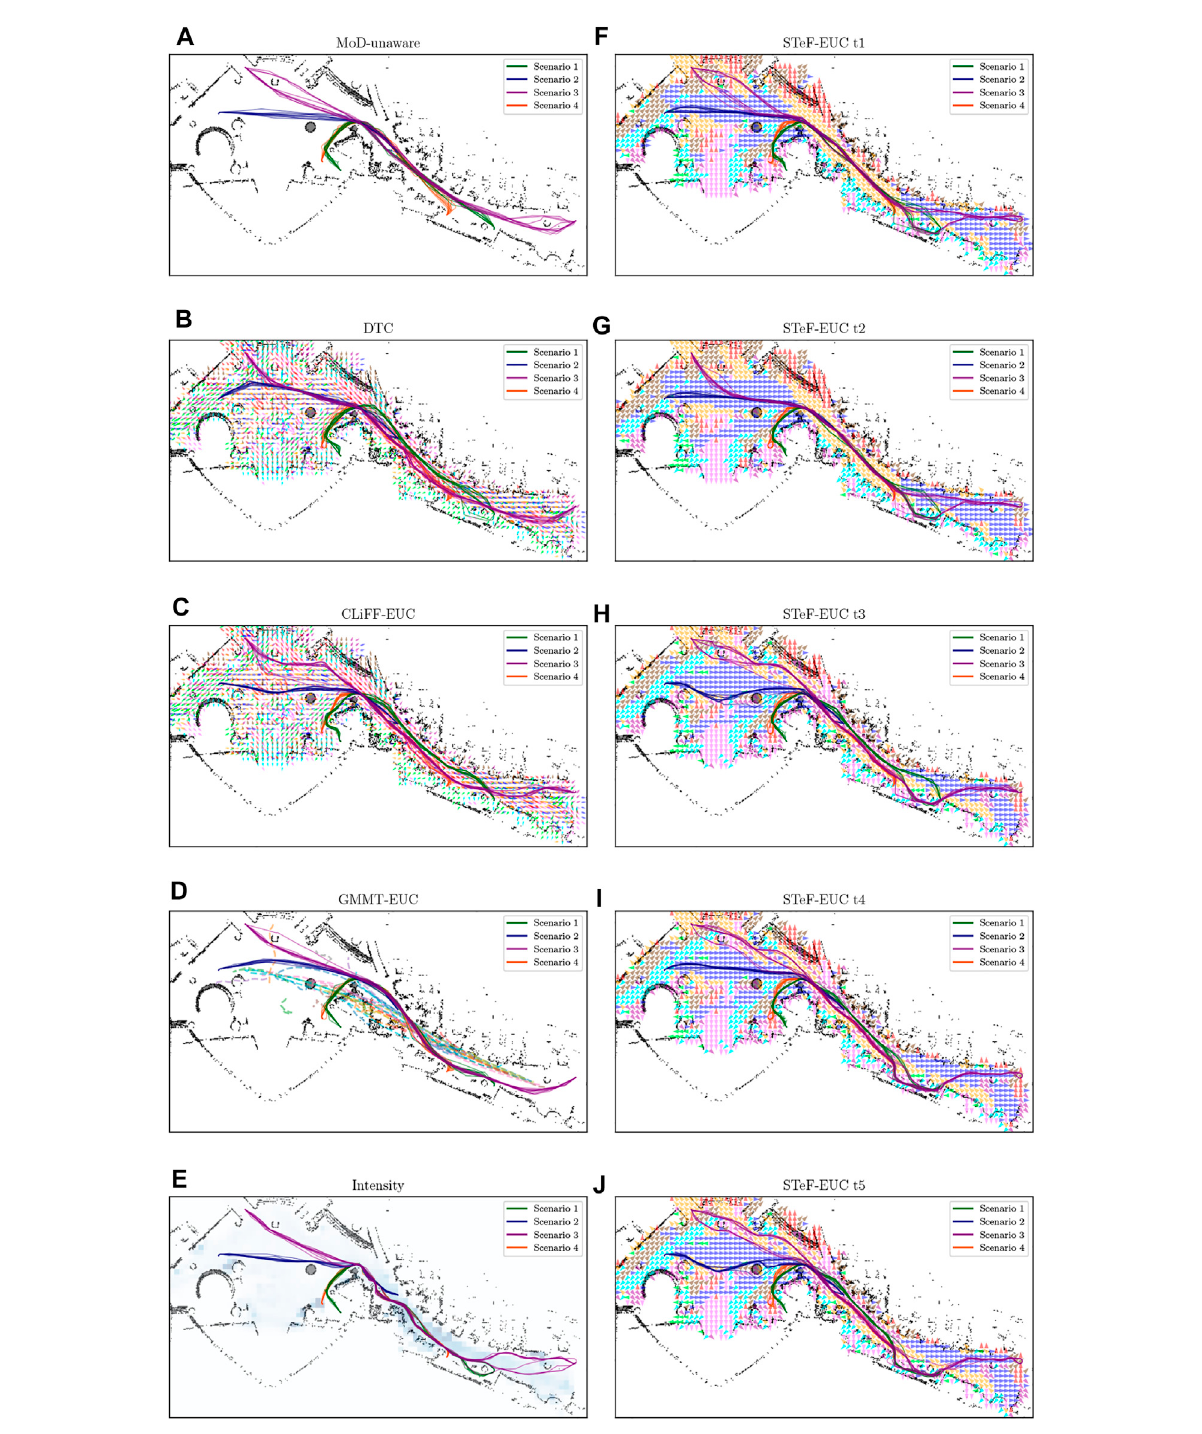
FIGURE 7 ThedifferentMoDmapsandpathsgeneratedbytherespectiveplanners (A – E) intheATCenvironment.TheSTeF-mapplots (F – J) showarrows in each cell that corresponds to the discretized orientation with the highest predicted probability of motion at the respective